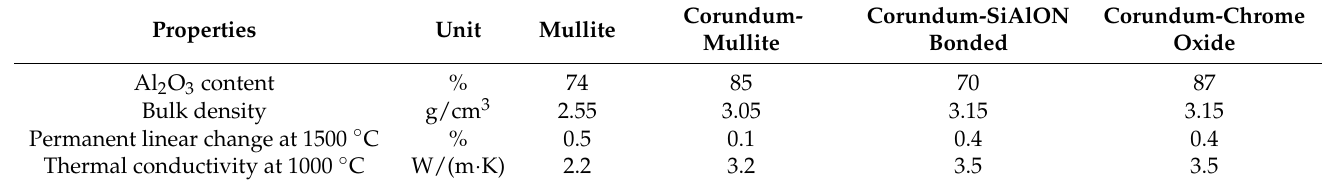
Table 2. Properties of different oxide bricks in hearth lining, data were compiled from